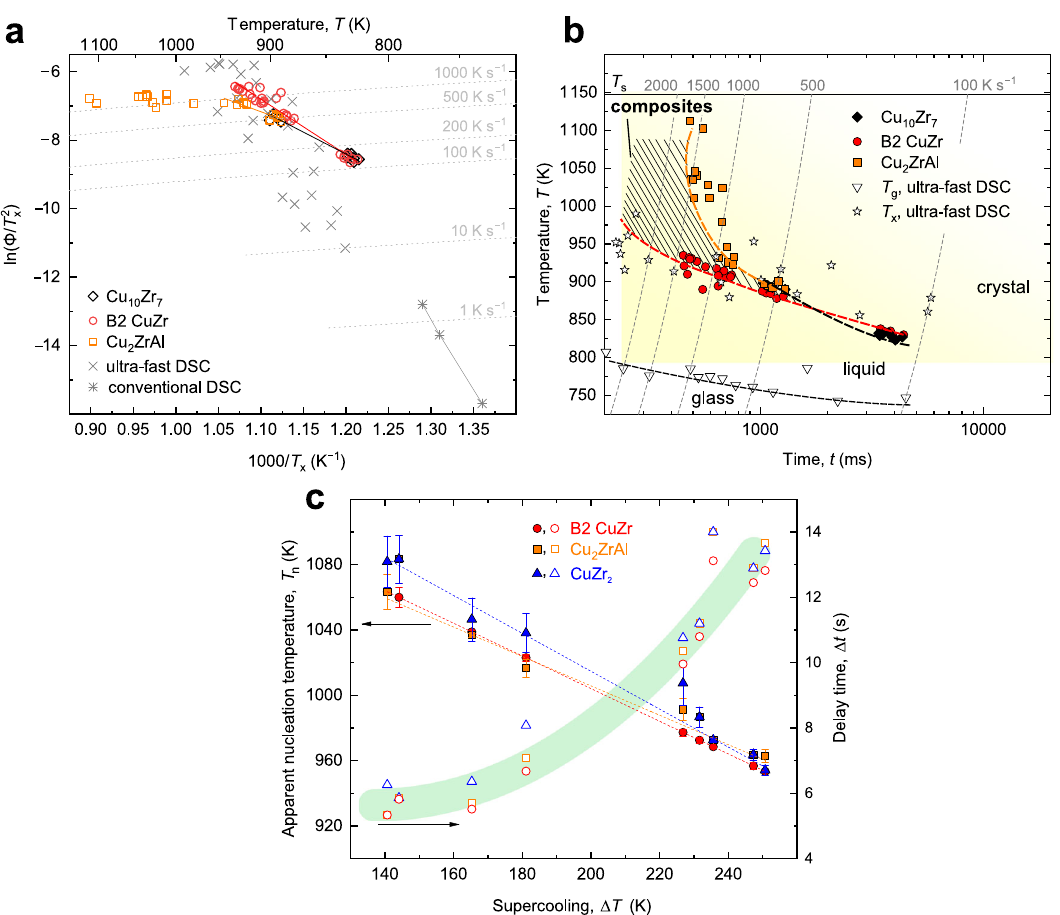
Fig. 6 Correlating the kinetics and phase-transformation mechanism in metallic-glass Cu 47.5 Zr 47.5 Al 5.0 . a A Kissinger plot for the crystallization of the individual phases during fl ash-annealing. The CuZr 2 phase is not plotted because it could not be unambiguously resolved during fl ash-annealing. The apparent activation energies for crystallization are shown by the solid lines representing best- fi ts by assuming Arrhenius kinetics. The ultra-fast-heating (FDSC) and conventional calorimetry data for T x are taken from Cheng et al. 28 The dashed contours show the nominal heating rates. b Continuous-heating- transformation phase diagram for fl ash-annealing (present work) and for ultra-fast differential scanning calorimetry taken from the literature 28 . Only T g obtained by FDSC is shown as this can be measured more accurately than by fl ash-annealing. The plotted nominal heating rates in K s − 1 are based on values obtained from FDSC. The range of temperature and heating rate under which ductile composites can be formed during fl ash-annealing is highlighted by the hatched area. c The dependence of the apparent nucleation temperature, T n (left-hand axis — full symbols) and the delay time, Δ t – de fi ned as 0 s at T – (right-hand axis – open symbols) on supercooling ( Δ T = T − T ) obtained by containerless solidi fi cation via electromagnetic levitation. The dashed lines l l show linear best- fi ts to the experimental data. For T n and Δ t n at large Δ T , the error bars are smaller than the symbols